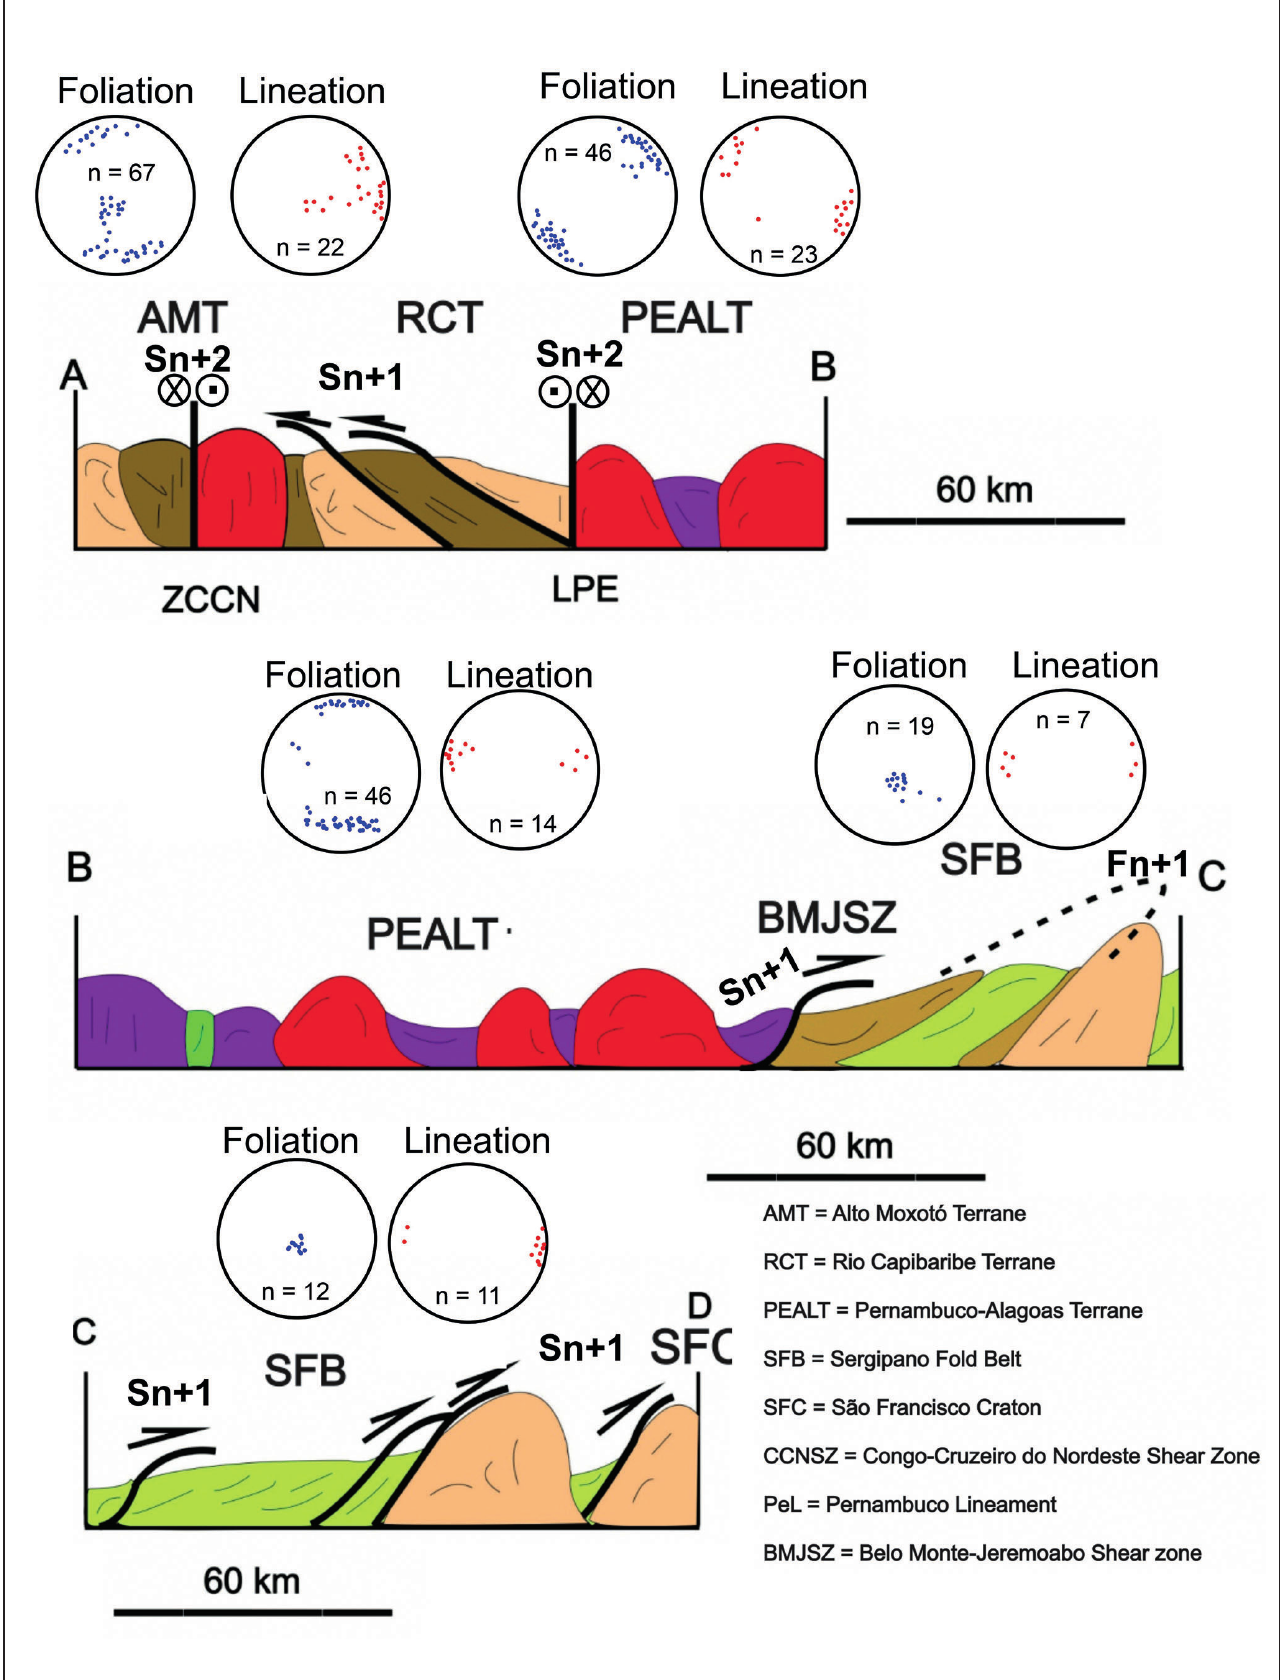
FIGURE 3 . Geological section among the main domains addressed and stereographic projections (lower hemisphere) of Schmidt- Lambert net to show the plot of the structural